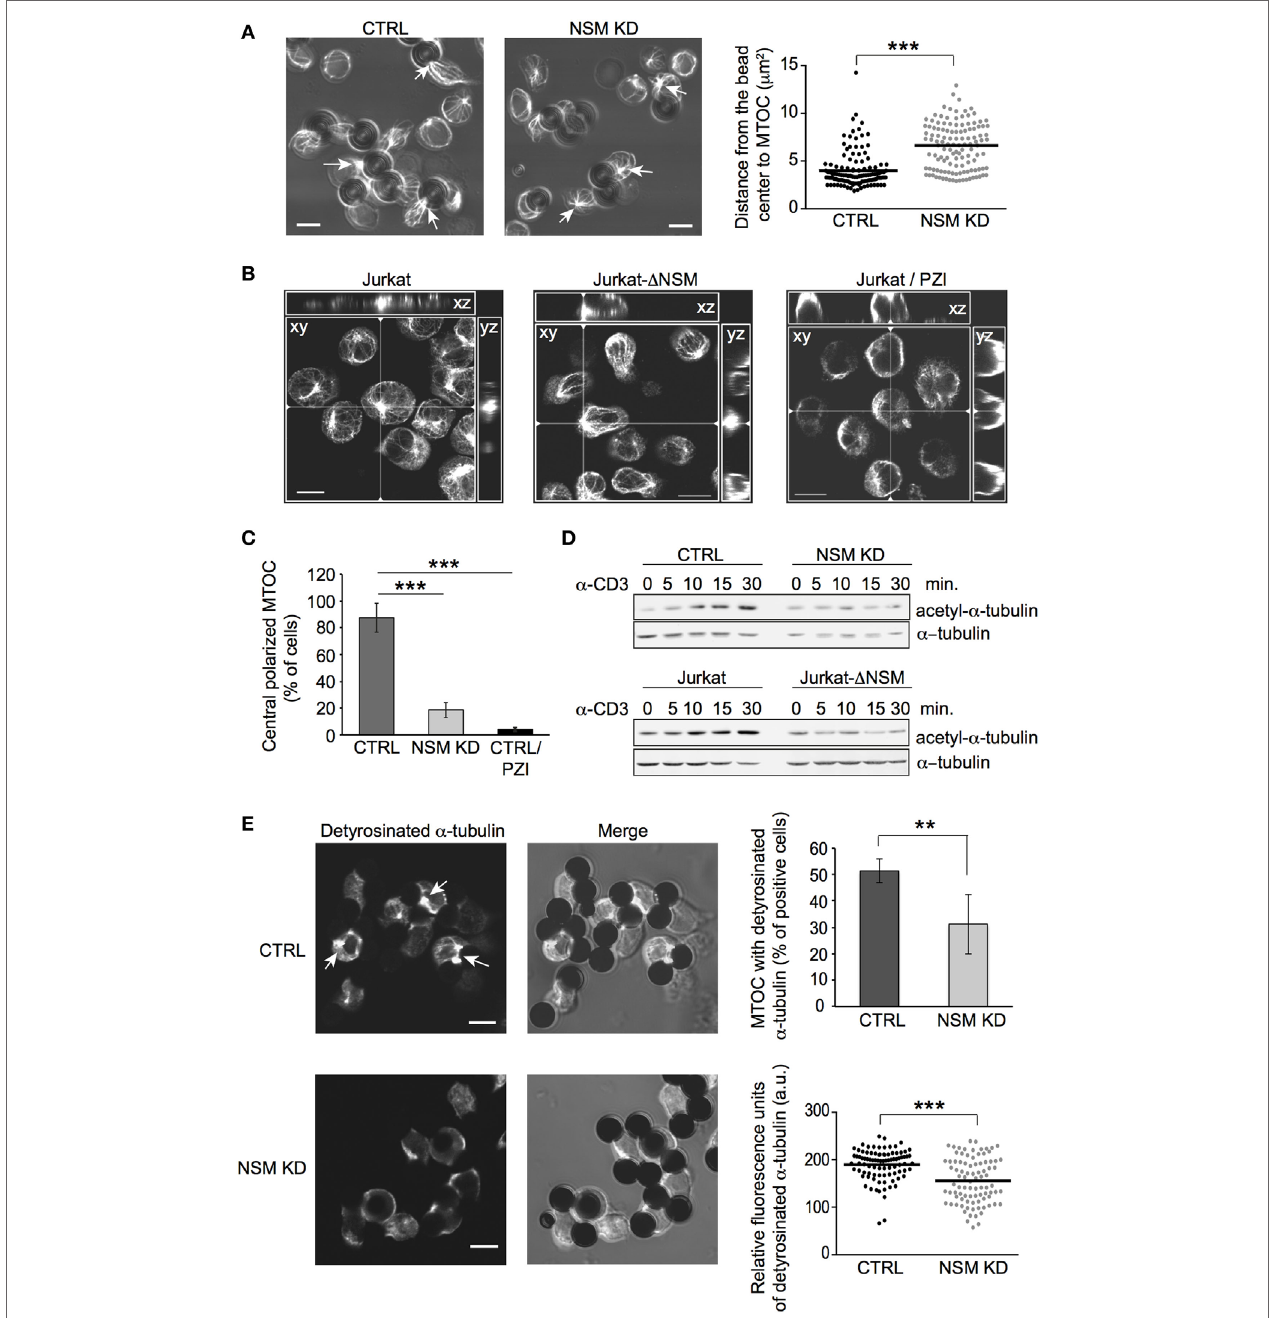
FigUre 6 | NSM is required for microtubule-organizing center (MTOC) translocation and dynamic reorganization of microtubule. (a) MTOC (detected by β -tubulin staining) immune synapse (IS) redistribution was determined in CTRL and NSM KD cells 15 min after stimulation with α -CD3-coated beads (examples shown in left panels). Quantification was based on the distance between bead center and MTOC, which should be less as 4 µm to consider MTOC as polarized (right panel). Arrows show examples of polarized MTOC in CTRL and non-polarized MTOC in NSM KD cells. Size bars: 5 µM. (B,c) Jurkat- Δ NSM and parental Jurkat cells (the latter pretreated with the PKC ζ inhibitor PZI or not) were stimulated by α -CD3 on stimulatory surface coated with crosslinking antibody. MTOC structures were defined as polarized, if they were positioned in the center of cell body and recruited to the site of stimulatory surface ( xz , yz views). Summary of evaluation of at least 70 cells in z-stacks for each condition is shown in (c) . Size bars: 10 µM. (D) Accumulation of acetyl- α -tubulin was determined in CTRL and NSM KD (upper panels) or parental and Jurkat- Δ NSM cells (bottom panels) after α -CD3-stimulation over time in Western blot. (e) Detyrosinated α -tubulin was detected in α -CD3-bead stimulated CTRL and NSM KD cells (IF pictures, accumulation of detyrosinated a-tubulin at IS is depicted by arrows). Percentage of cells staining positive for MTOC with detyrosinated α -tubulin is shown in upper right graph. Only cells with detyrosinated MTOC were taken for analysis of fluorescence signal intensity by ImageJ software in lower right graph. Size bars: 5 µM.